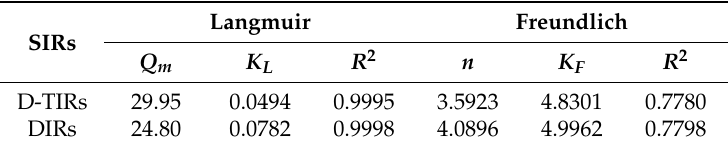
Table 2. Fitting parameters of Langmuir and Freundlich isotherm.